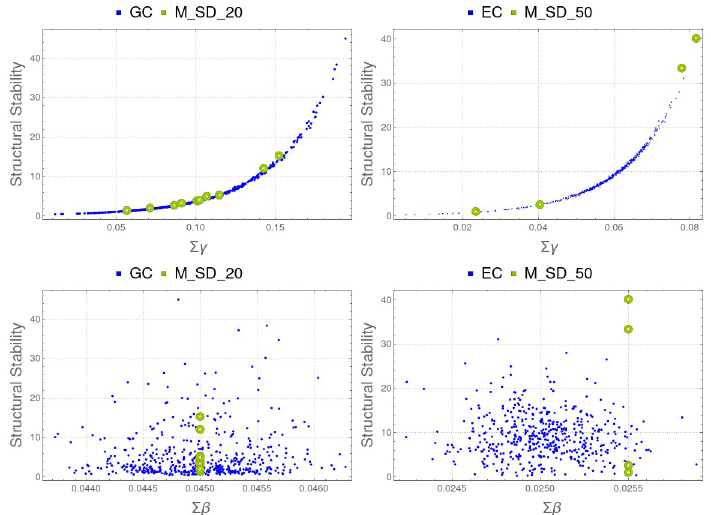
Fig 10. Sum of cooperation ∑ γ ij (top row) and competition ∑ β ij (bottom) versus structural stability in graphs with random antagonistic edge weight: GC (left) and EC (right). Correlations for ∑ γ Results indicate that the relationship of structural stability is direct to the sum of the cooperation coefficients but it is not correlated with the sum of the competition ones.